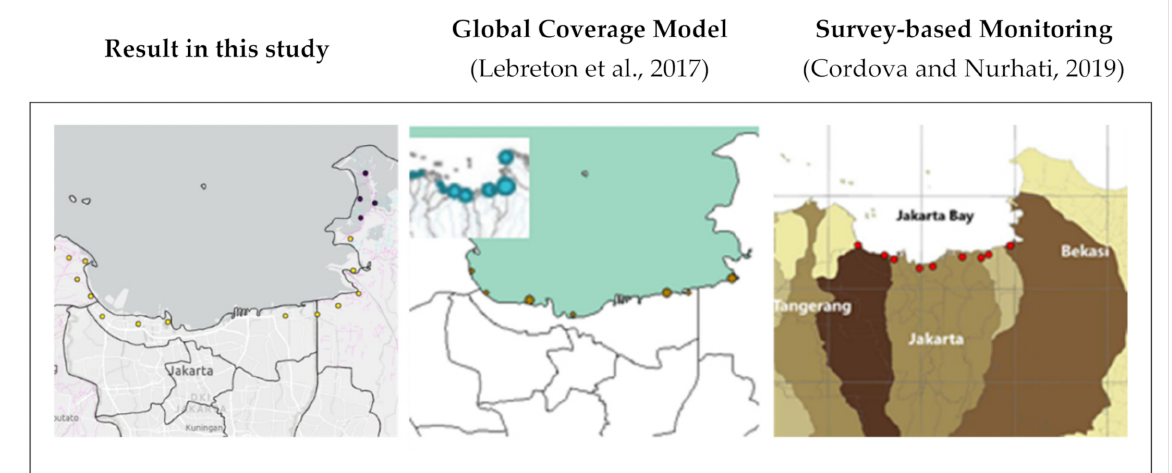
Figure 13. Result comparison of plastic debris accumulation research in the estuaries at Jakarta